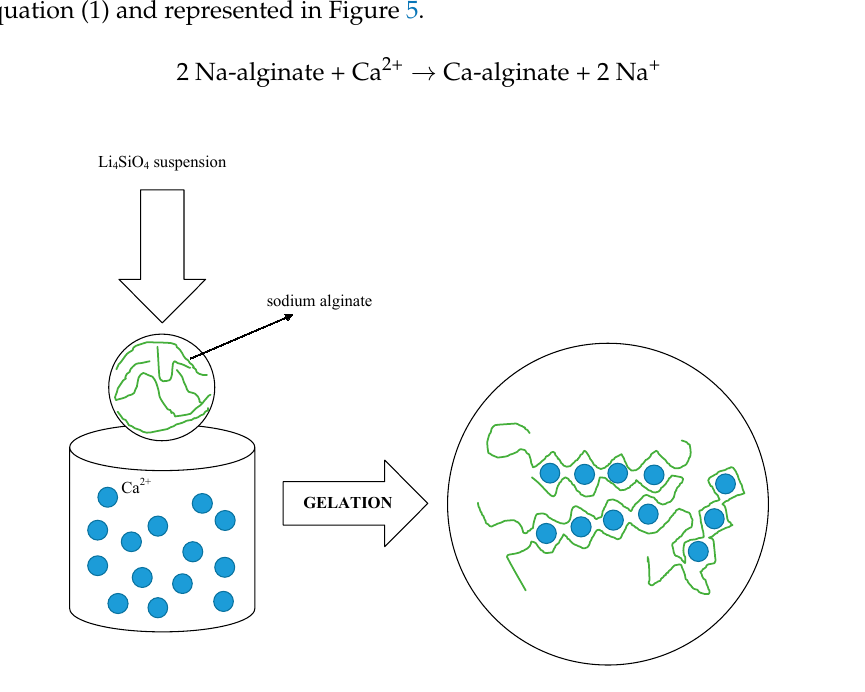
Figure 5. Drip-casting gelation process with sodium alginate.